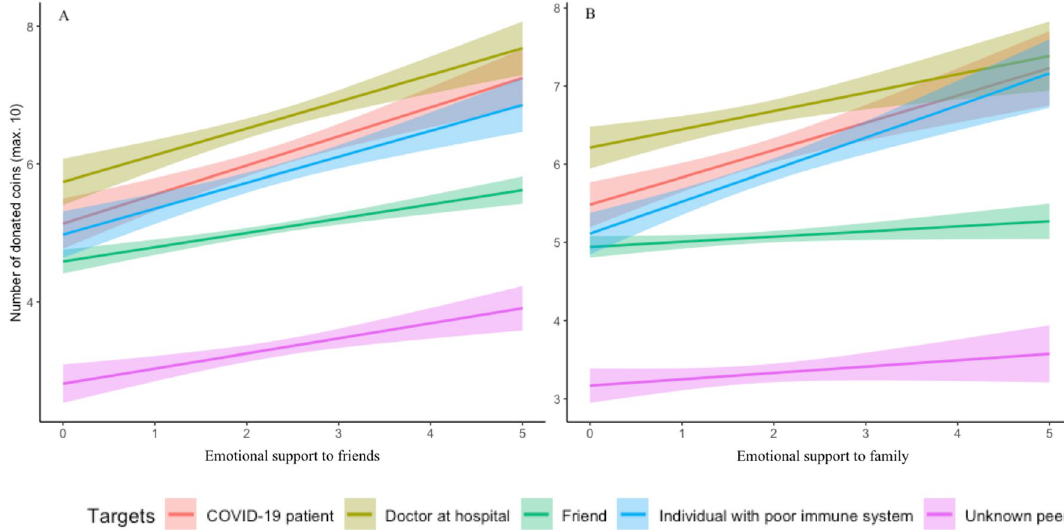
Figure 7. Interaction effect between emotional support to friends ( A ) and family ( B) as measured at T1 and giving toward all targets, averaged across the first two timepoints (T1 day 1 with N = 857, T1 day 10 with N = 752, and T2 with N = 473). Higher levels of daily emotional support towards friends were associated with more donations to others. Adolescents with higher levels of emotional support towards family donated more coins to COVID-19 patients and individuals with a poor immune system, but not to the other targets. Band widths indicate 95% confidence